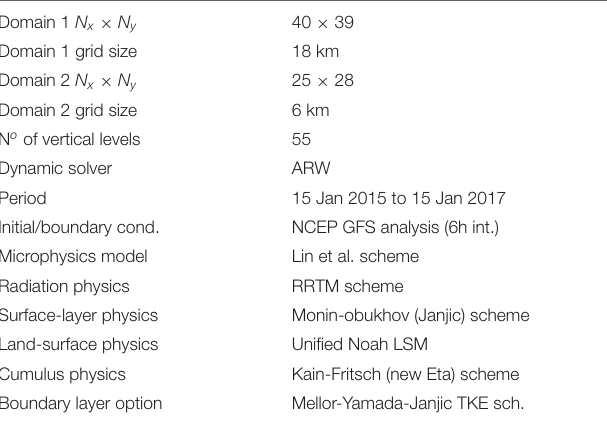
TABLE 1 | Overview of WRF configuration for simulation of local wind time